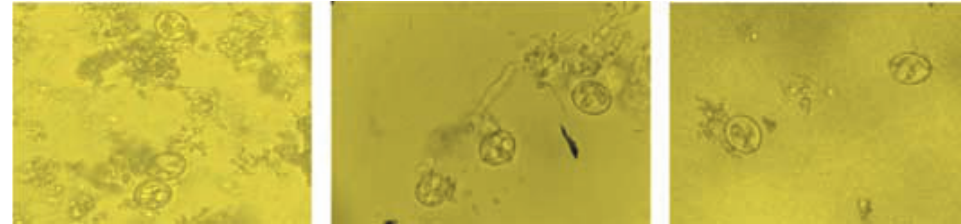
Fig.1. Sporulated oocysts of Eimeria